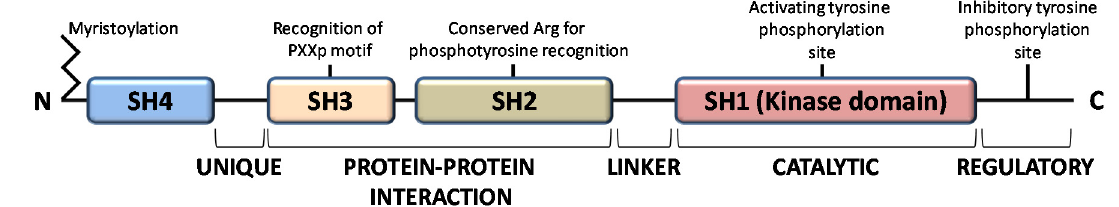
Figure 1. Domain structure of Src family kinases.